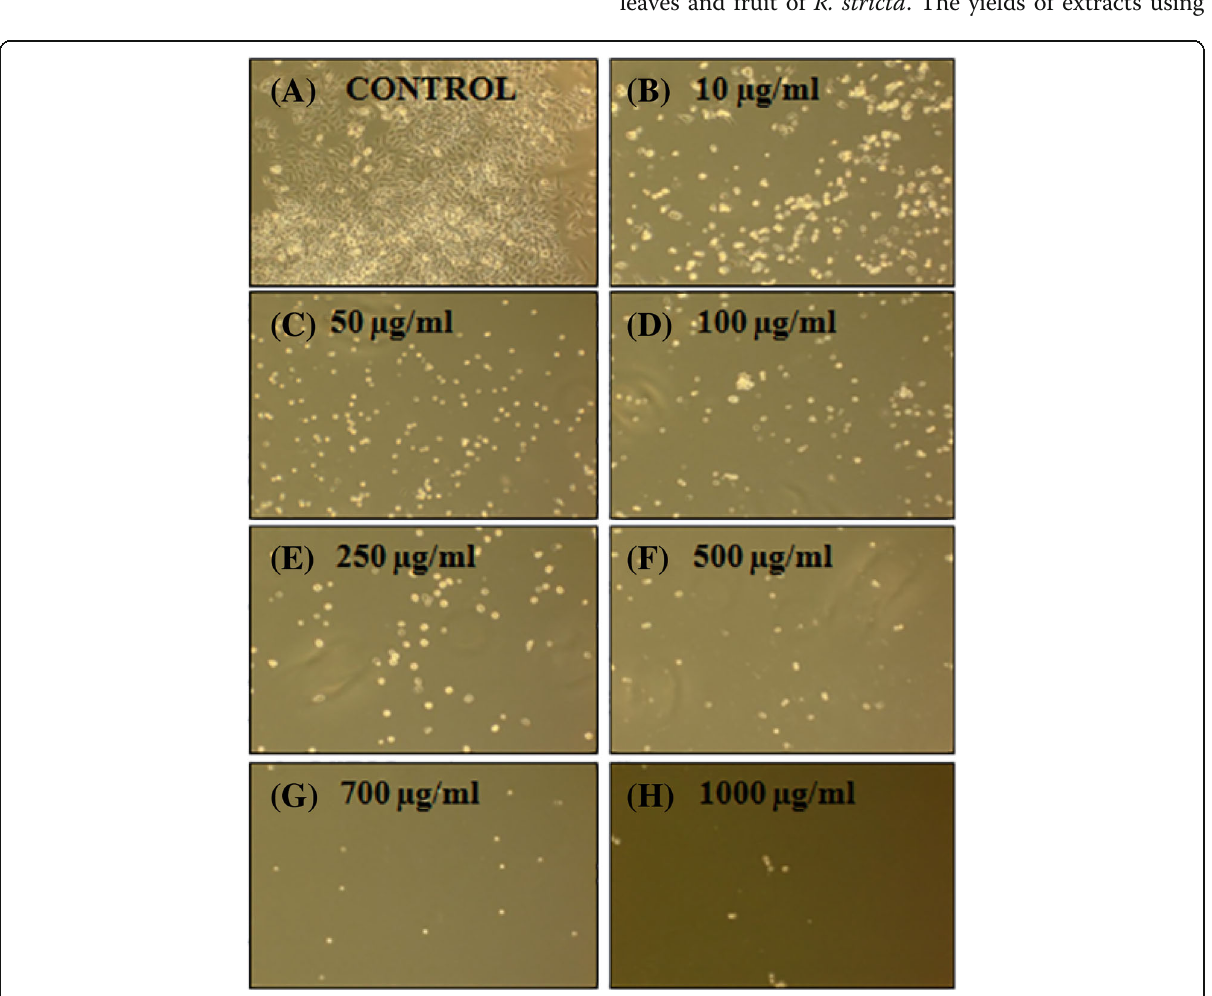
Fig. 2 Phase contrast micrographs of RS1S CHCL3 extract-induced changes in cellular morphology. NT2 cells were incubated overnight in 24-well plates in DMEM/F12 medium, and then RS1S CHCL3 extract was added to the medium. After 48 h of treatment, the cells detached from the plates, and the cell shape changed from flat to round in a dose – dependent manner. a Vehicle control, b – h increasing concentrations of the extract were added to the cultures for 48 h. Magnification (10×)